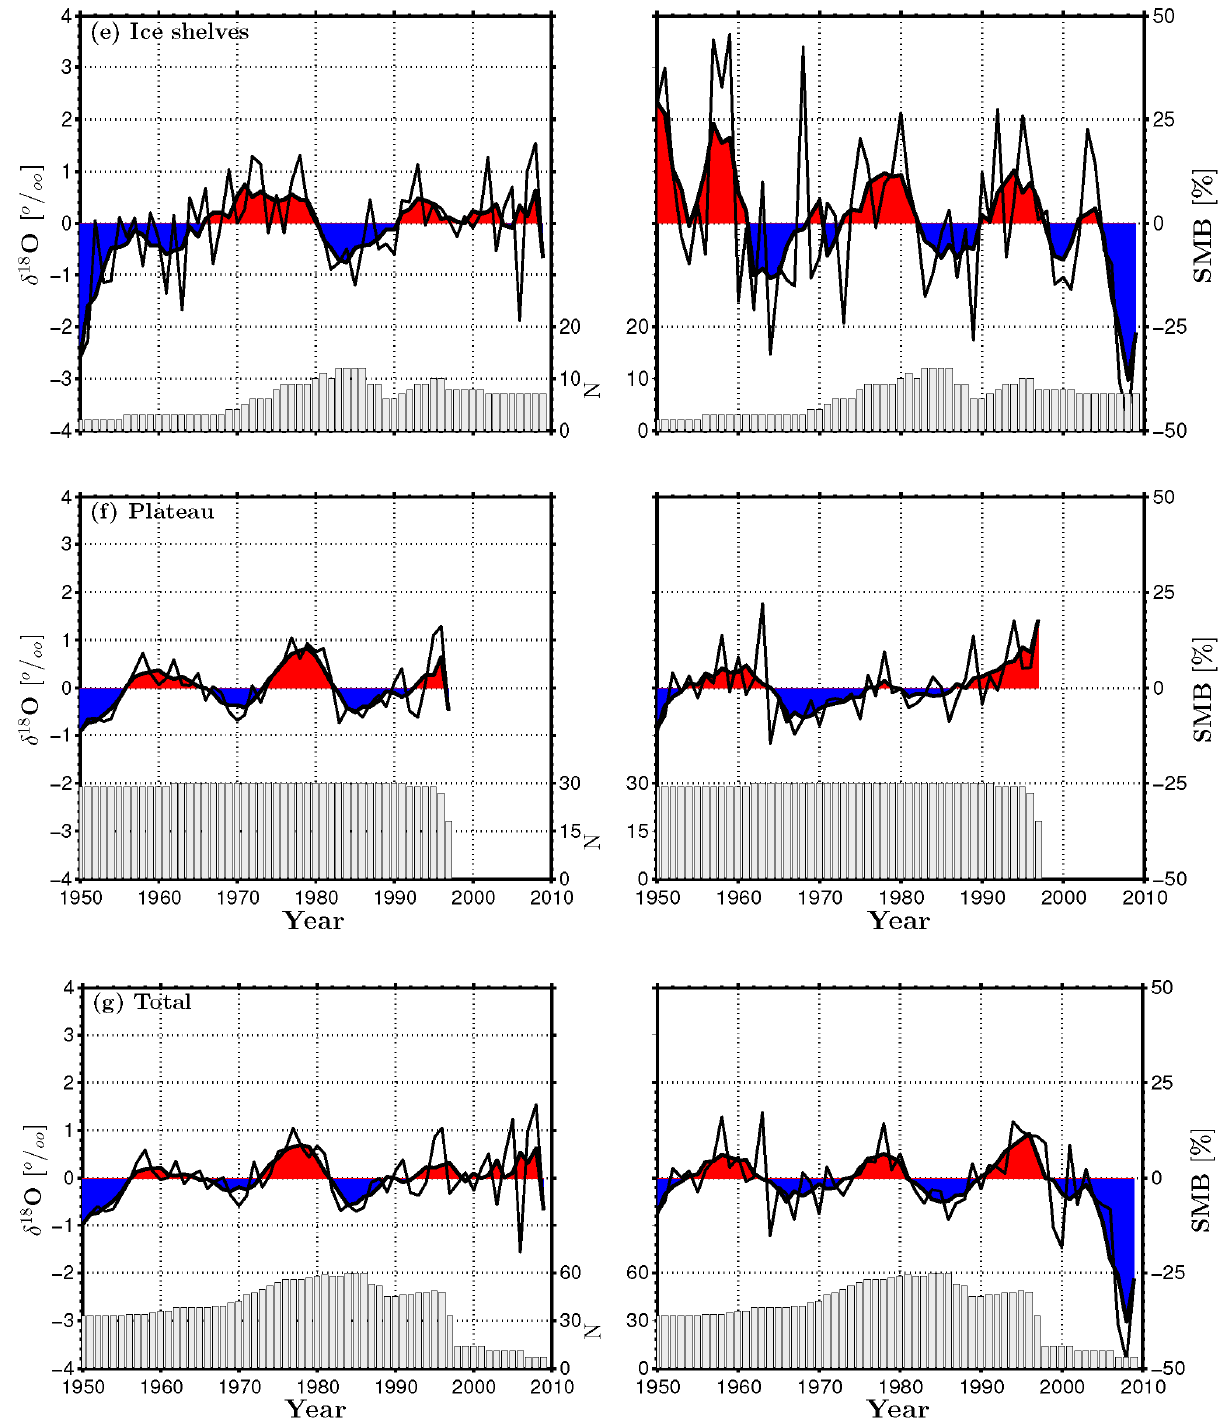
Figure 6. Composite records of δ 18 O as deviation from the mean (‰) (left) and the SMB as deviation from the mean (%) (right): (a) Ekström Ice Shelf, (b) Ekström Ice Shelf and adjacent ridges, (c) Fimbul Ice Shelf, (d) Ritscherflya, (e) ice shelves (all), (f) plateau and (g) total. Also shown is a 5-year moving average (thick red and black lines). The grey bars indicate the number of cores that contribute to the composite records. The shaded areas represent time periods with positive (red) and negative (blue) deviations from mean.